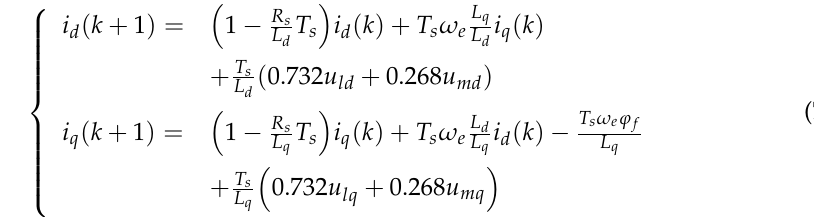
Figure 3. Virtual voltage vectors in the α - β subspace.